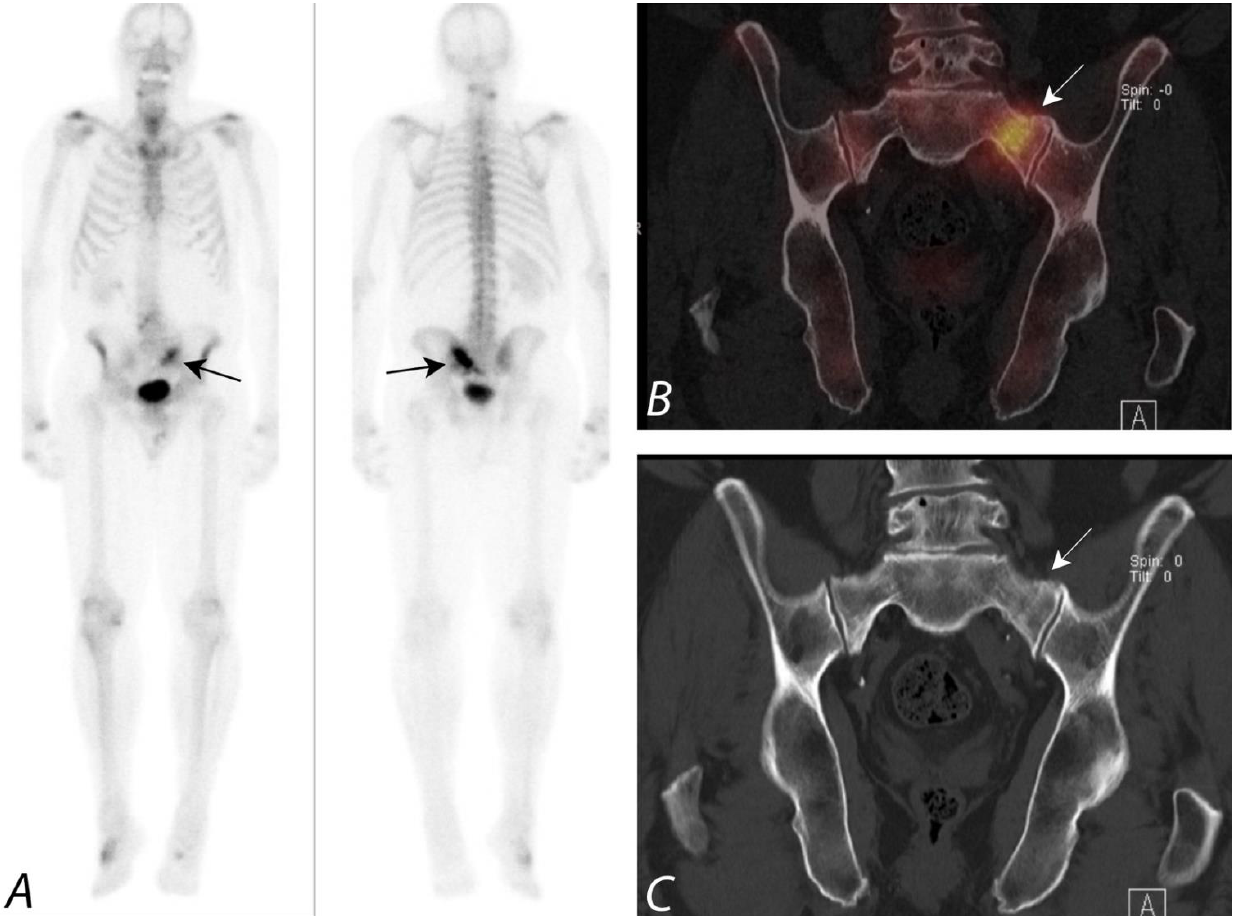
Figure 3. Anterior and posterior whole body 99m Tc MDP bone scan planar images ( A ) from a Tc-99m MDP bone scan in a 68-year-old male with prostate cancer and new pelvic pain demonstrate focal uptake (black arrows) localizing to the left sacral region. Coronal CT and fused SPECT/CT images ( B , C ) demonstrate the uptake localizing to a vertical insufficiency fracture of the left sacral ala, which demonstrates osteoblastic activity, confirming a healing insufficiency fracture and not metastatic disease.